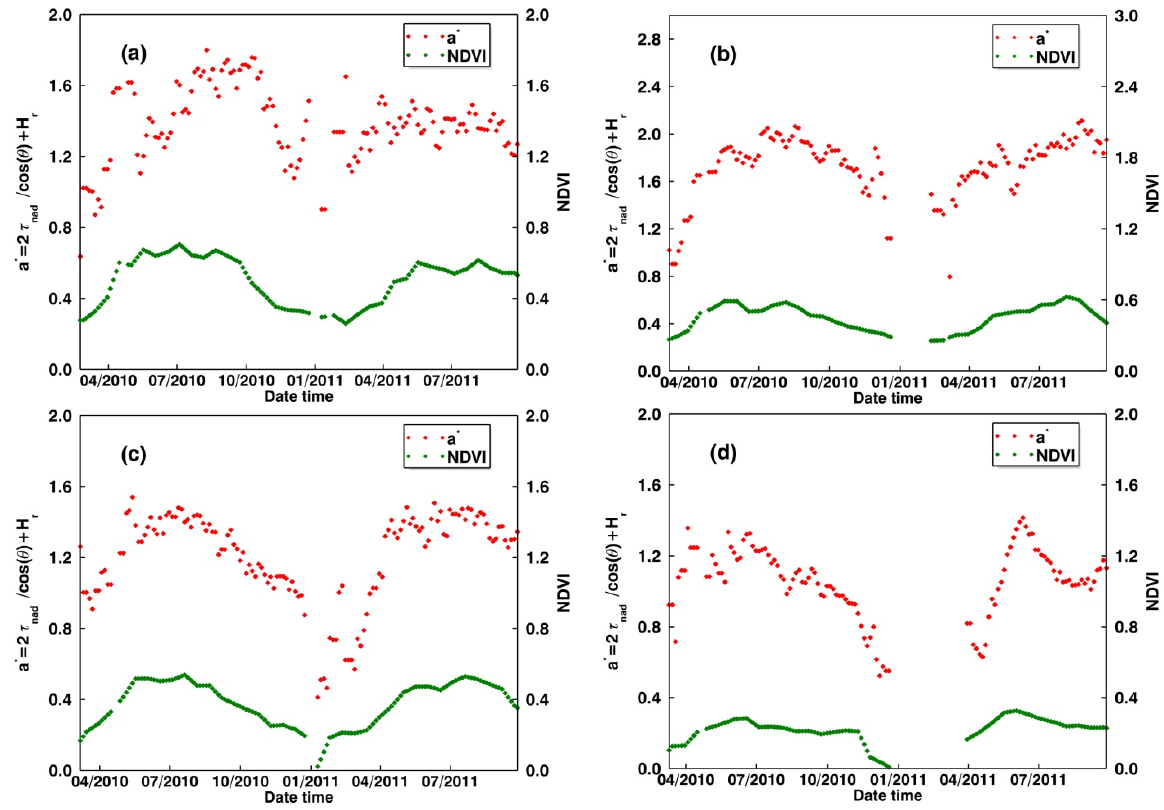
Figure 2. Time series of the (cid:1853) ∗ parameter and of the MODIS NDVI over SCAN sites, ( a ) 2092, ( b ) 2093, ( c ) 2018, and ( d ) 2160 (January 2010–September